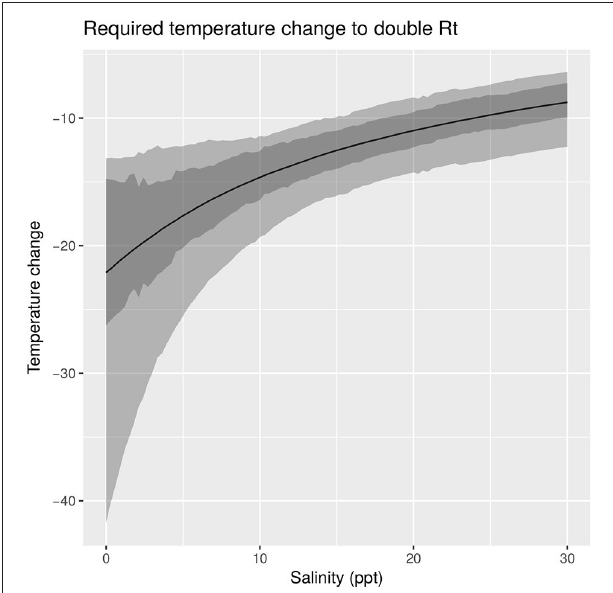
FIGURE 5 | Temperature change in response to increasing salinity required to double resistance time. Note the negative scale of temperature, indicating that at higher salinity (parts per thousand) the temperature decrease required to double the time to inactivate 90% of the initial virus titer is less in average than at lower salinity levels. Shades of gray indicate the 95 and 68% credible